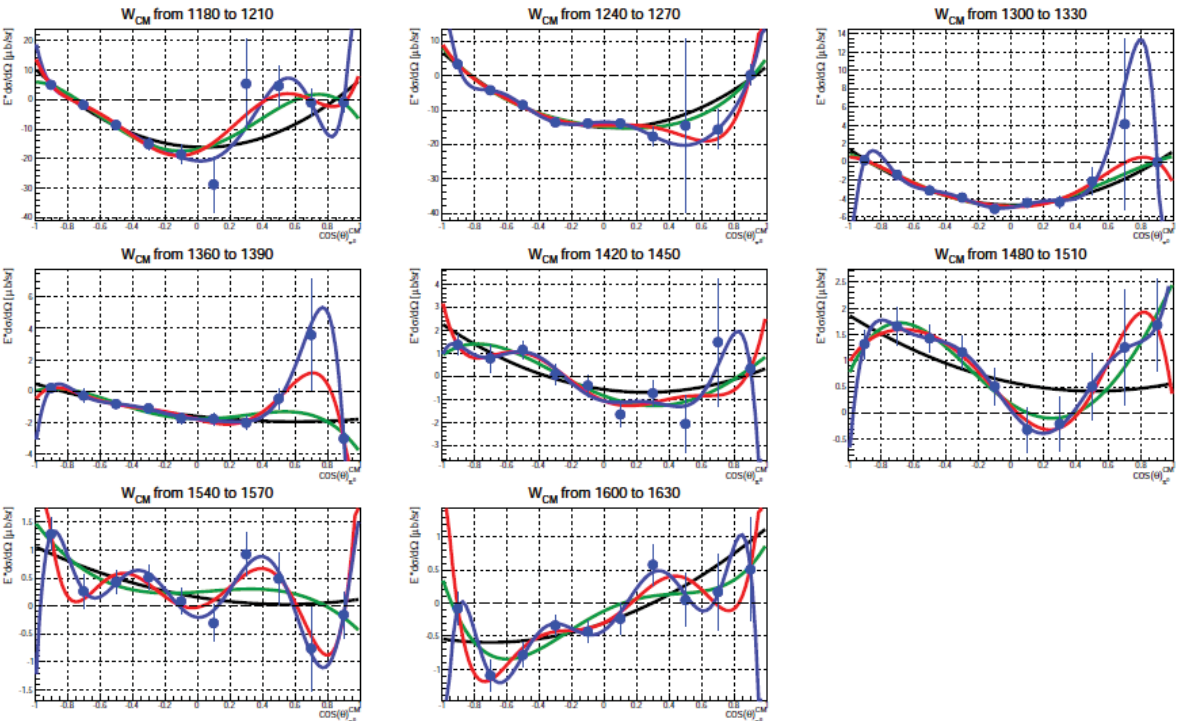
Figure 9. Samples of ˆ E for the π 0 p channel, fitted with associated Legendre polynomials truncated at l max = 1 (black), 2 (green), 3 (red) and 4 (blue)